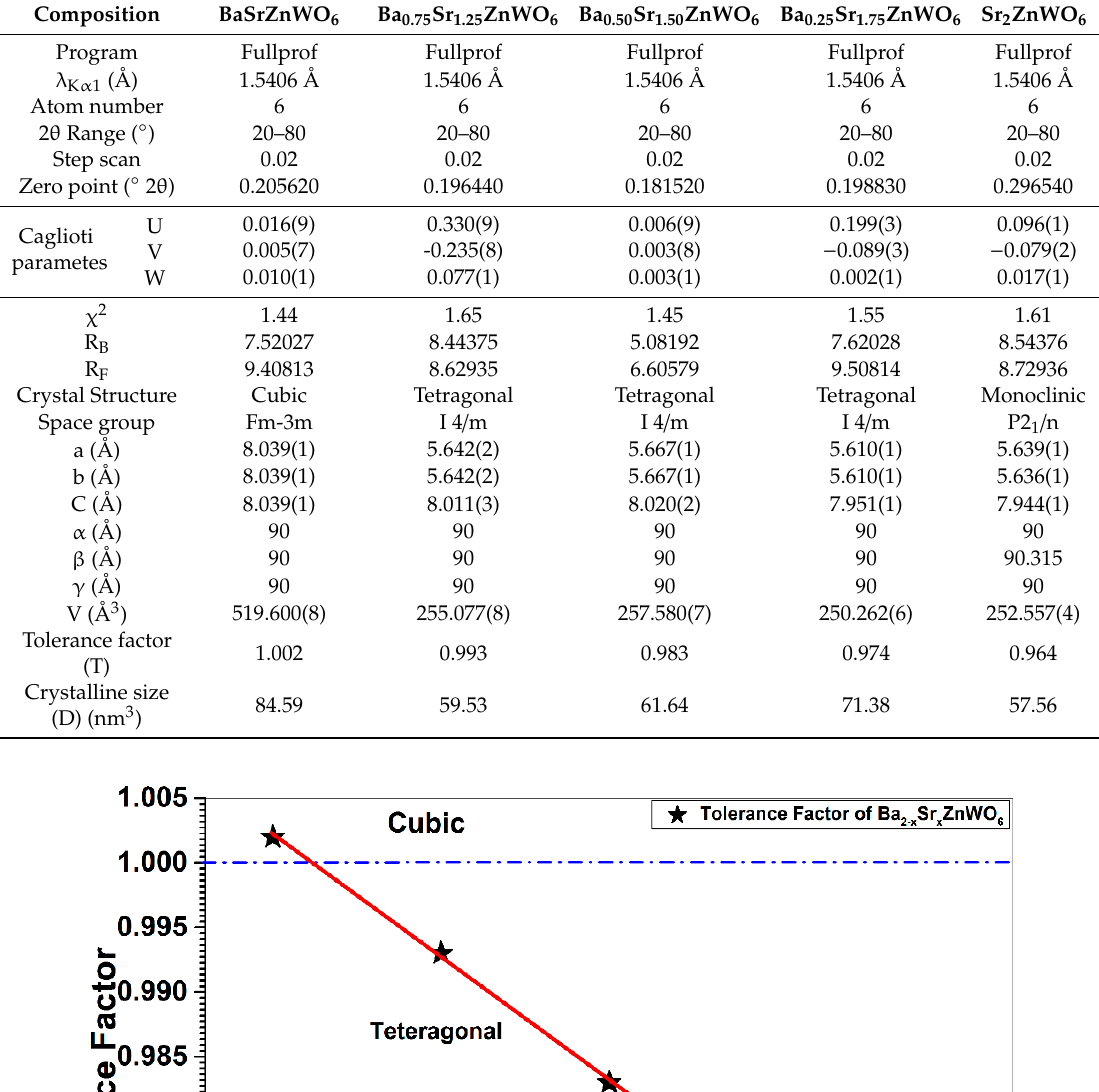
Table 1. Unit cell parameters, tolerance factors, and crystalline sizes of the Ba 2 − x Sr x ZnWO 6 (x = 1, 1.25,